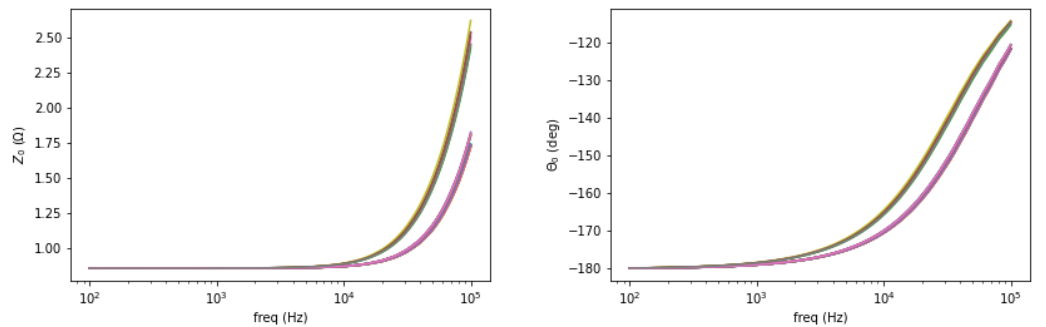
Figure 2. Free space background measurement of amplitude ( left ) and phase ( right ) for 28 coil-pair combinations.